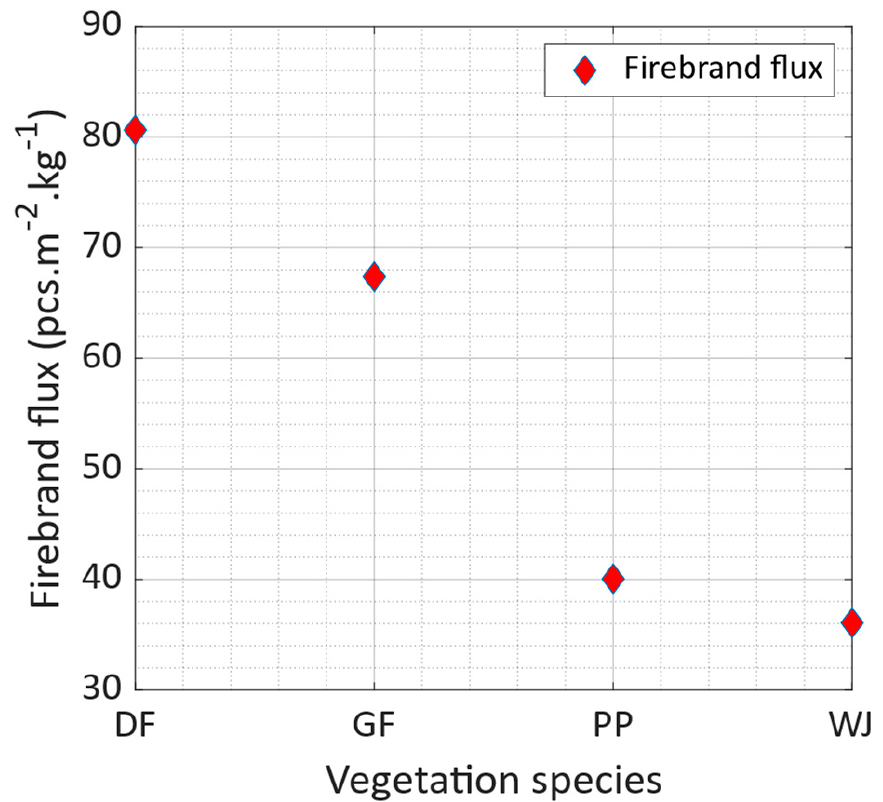
Figure 16. Firebrand flux per kilogram of fuel consumption of Douglas Fir (DF), Grand Fir (GF), Ponderosa Pine (PP), and Western Juniper (WJ) vegetation species [6].